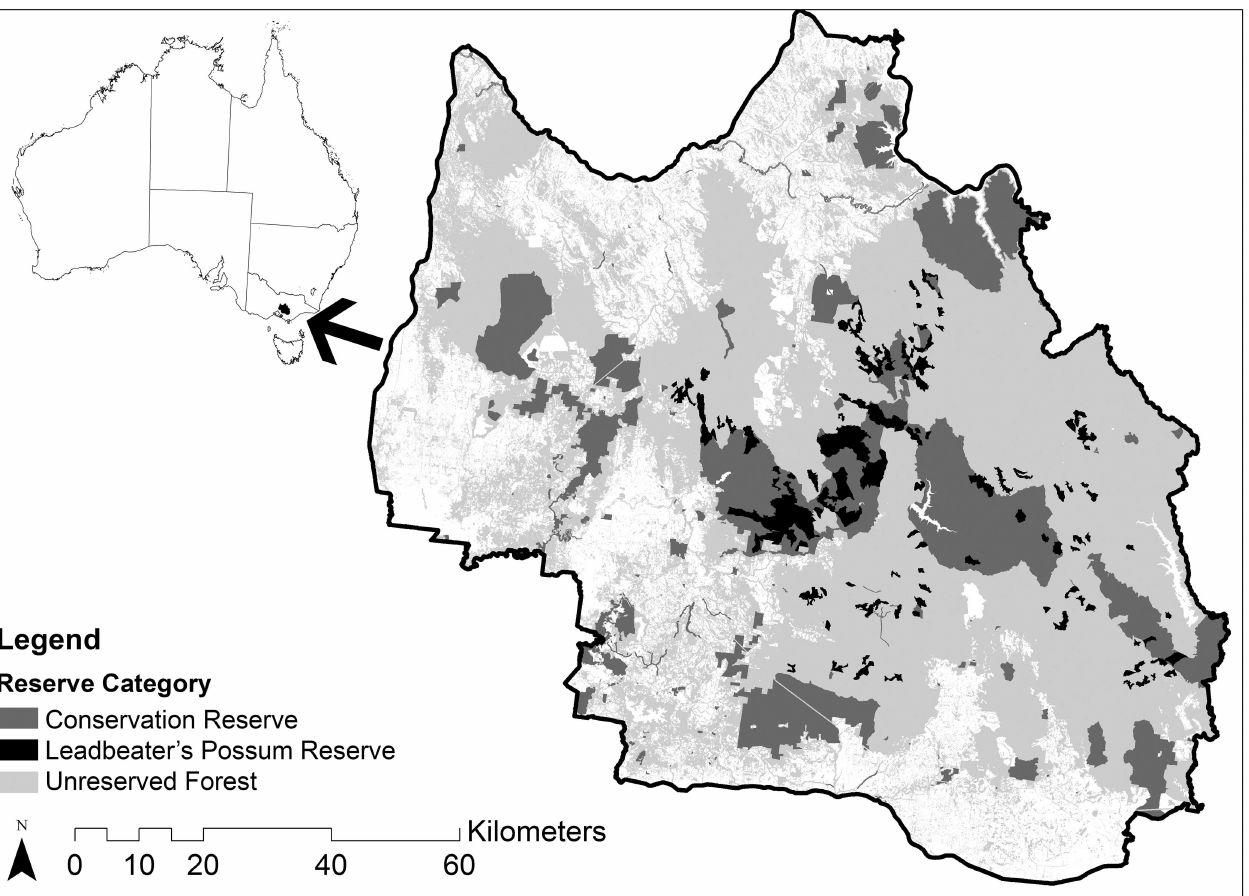
Fig 1. The existing conservation reservenetwork and the Leadbeater’s Possum Reserve in the study area (Source: